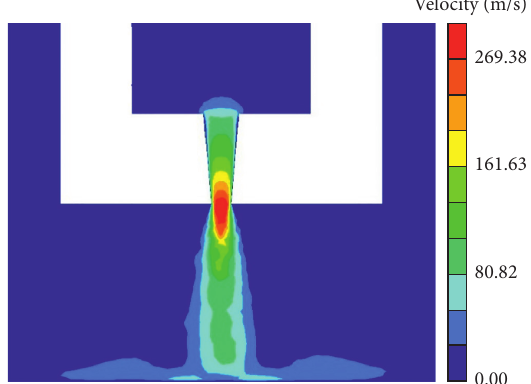
Figure 7: Backward jet velocity cloud diagram of the jet bit.